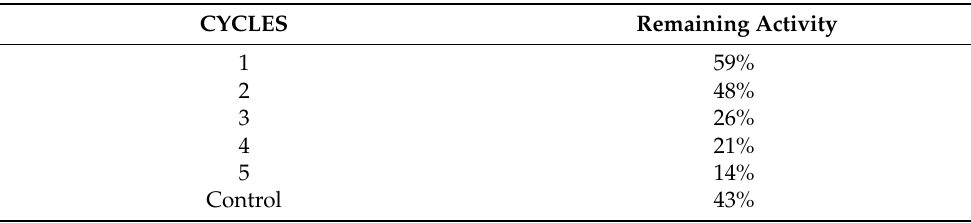
Table 3. Trypsin activity after successive synthesis cycles. Elution of high-affinity MIP nanoparticles was performed at pH 5.0. The activity was measured after 2 h at 405 nm.